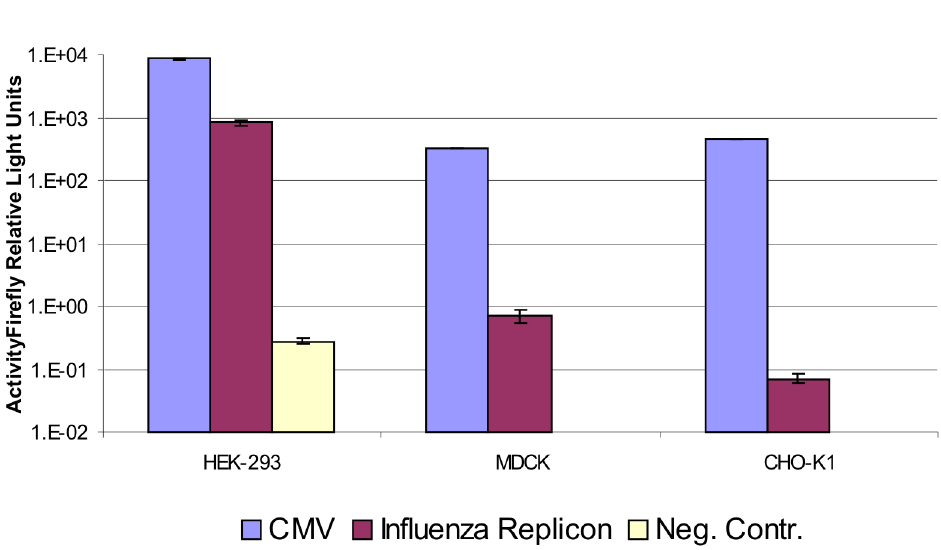
Figure 8. Activity of the influenza replicon in a human, a canine and a rodent cell line. HEK -293, MDCK or CHO-K1 cells were either tranfected with pcDNA-luc (CMV) or with the influenza replicon and pMono-lucNS (Influenza Replicon). The HEK-293 negative control has been transfected with pMono-lucNS and pBi-NP only. Additionally, pRL, coding for Renilla luciferase, was cotransfected in all cases. In case of MDCK and CHO-K1, untransfected cells have been used as negative controls and can therefore not be normalized, absolute values can be found in Results section. Cells were harvested 48 hours post transfection and subjected to luciferase assay. Data represents arithmetic mean values and standard deviation.